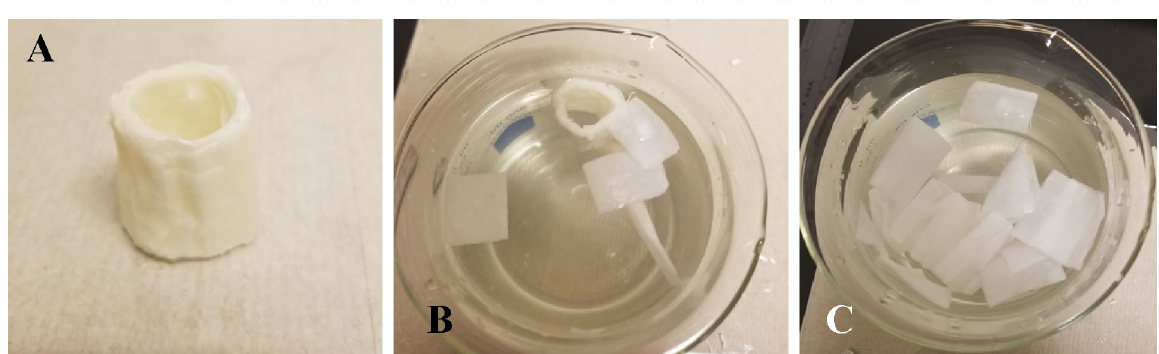
Figure 6. ( A ) Images of a fabricated device prior to placement in water bath; ( B ) the device starting to collapse/ disintegrate after about 10 min in water; ( C ) the device totally collapsed after about 30